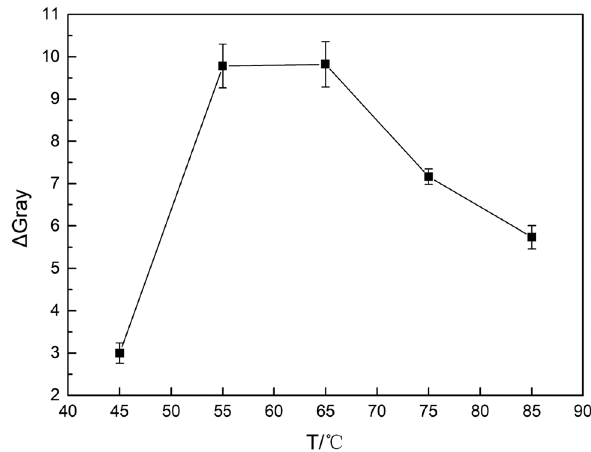
Figure 6: The e ff ect of temperature on color